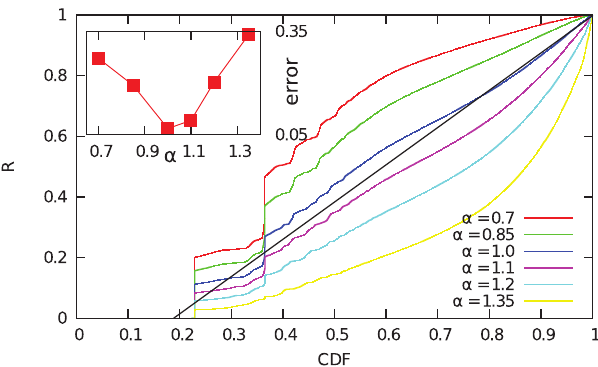
Figure 6. The average indegree of neighbors in the function of Figure 7. Rank function for new link creation. The cumulative ( k out ) . In networks without degree correlations, the the outdegree k in distribution function of the R values (see Eq. 5) for exponents nn degree of connected nodes do not depend on each other, therefore for 0 : 7,0 : 85,1,1 : 1,1 : 2 and 1 : 35 . The inset shows the Kolmogorov-Smirnoff such networks we expect that k in ( k out ) is constant. In the case of the error for these nn Bitcoin network, we observe a clear disassortative behavior: k in ( k out ) is nn a decreasing function, indicating that nodes with high outdegree tend to connect to nodes with low indegree.